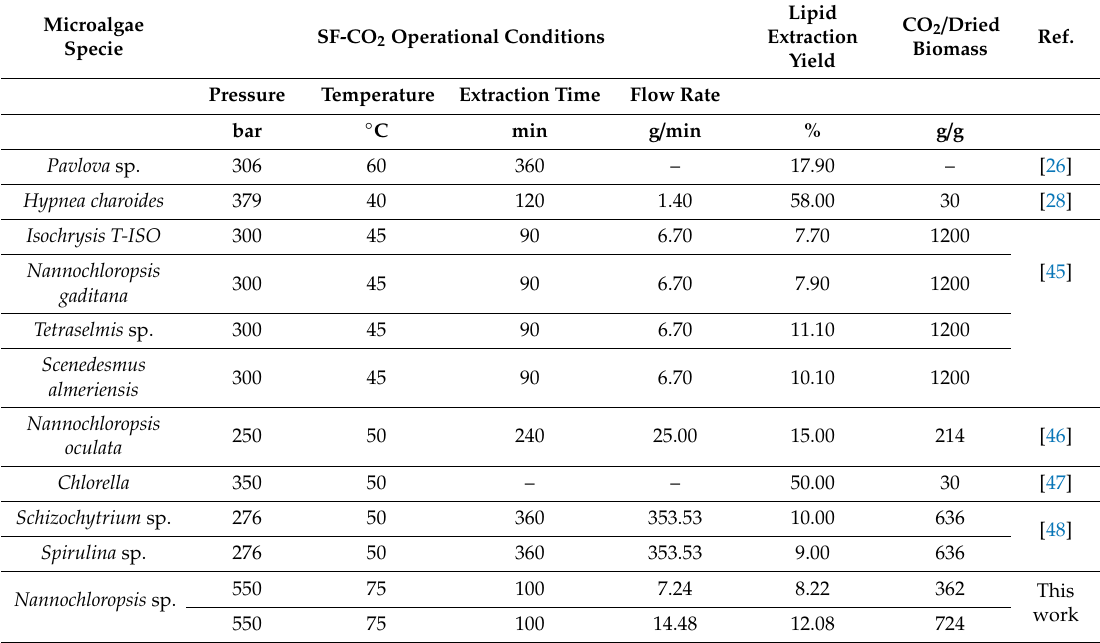
Table 3. Comparison between the operational conditions, adopted for SF-CO 2, the main results of this work, and other examples from the literature.